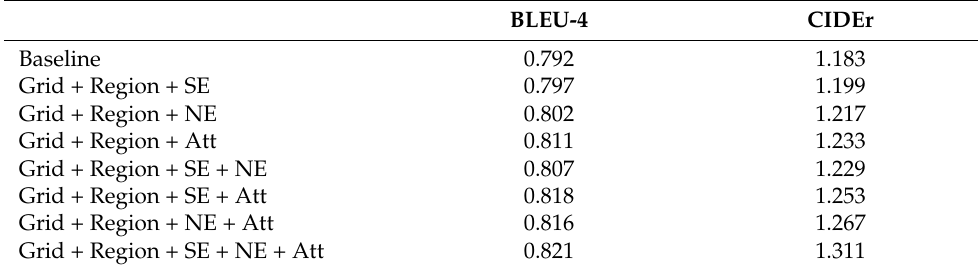
Table 3. Comparison of the performance of each part of the model.